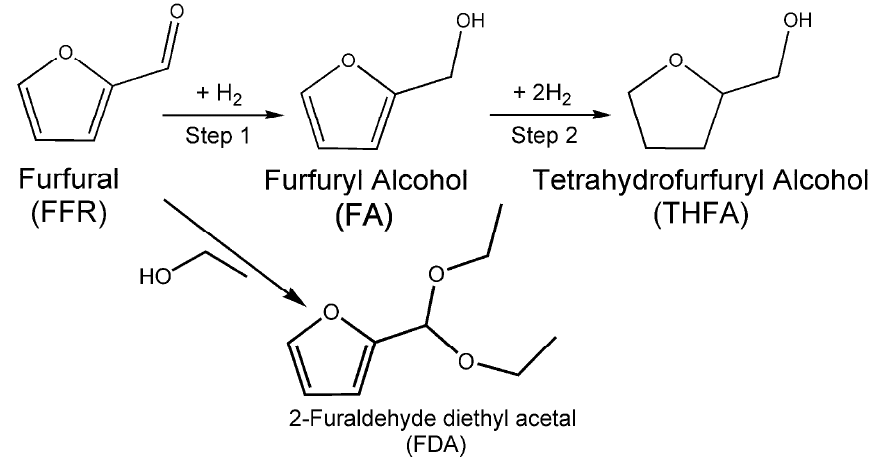
Scheme 1. Pathways for hydrogenation of furfural (FFR) to tetrahydrofurfuryl alcohol (THFA) via furfuryl alcohol (FA) and the formation of byproduct 2-furaldehyde diethyl acetal